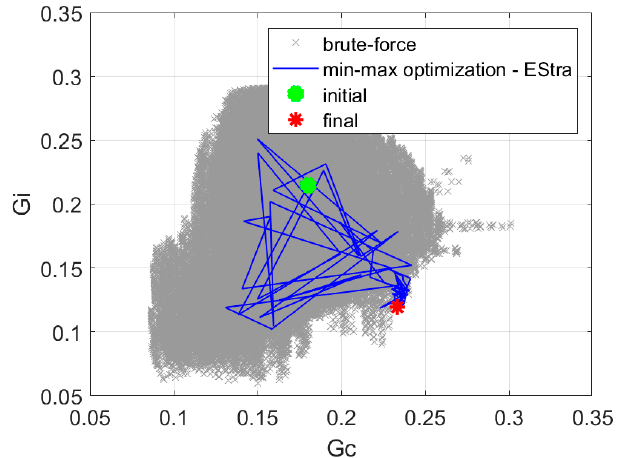
Figure 10. Figure 10. The history of optimization in the space of objective function components for min-max optimization.